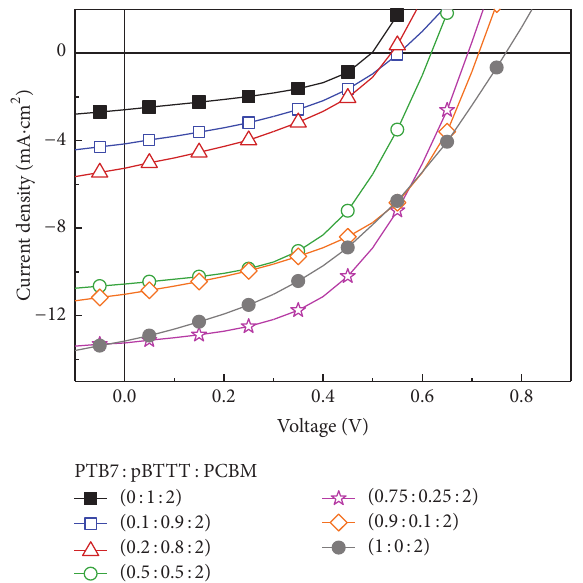
Figure 3: Current density-voltage ( J - V ) curves under AM 1.5G illumination (100mW ⋅ cm −2 ) of PV cells with active layers of PTB7: PC 61 BM (1:2), pBTTT:PC 61 BM (1:2), and five ternary blend active layers with different PTB7:pBTTT weight